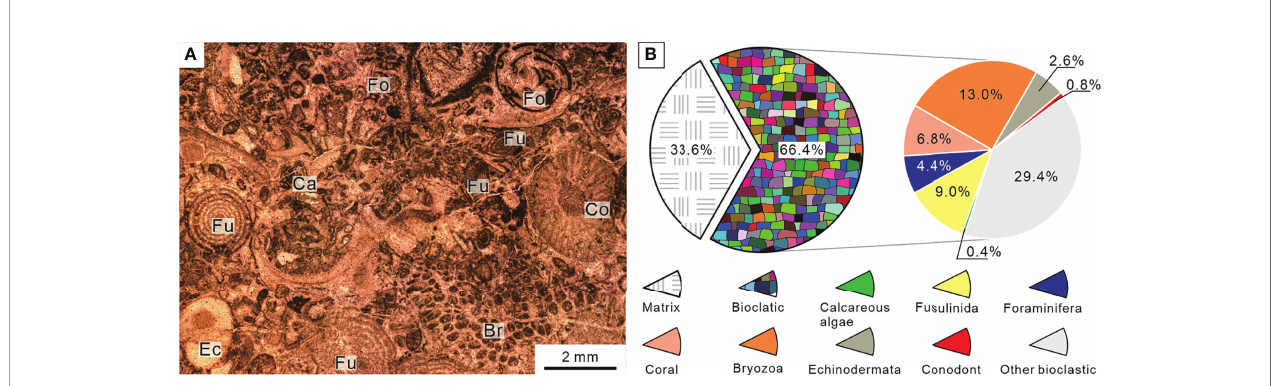
FIGURE 4 | Micropetrologic characters (A) and percentages of fossil assemblages (B) of bioclastic grainstones from Bed 1 in the Chongyang section before the PTME. Br, Bryozoa; Ca, Calcareous algae; Co, Coral; Ec, Echinodermata; Fo, Non-fusulinida foraminifera; Fu,